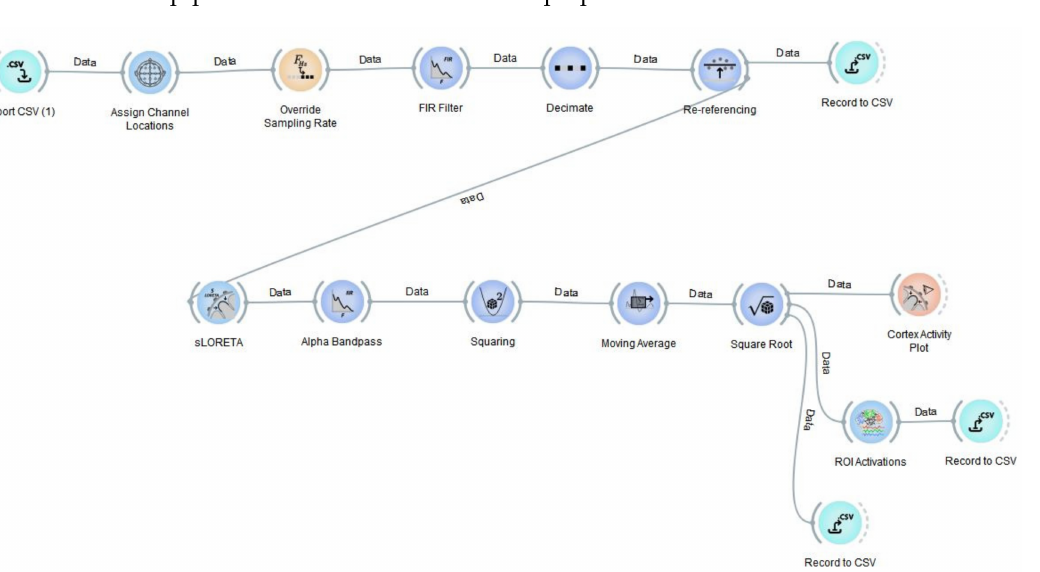
Figure 2. We used python-based Neuropype pipeline to process 2D scalp ERP data, which is extracted from EEG data after artifact removal, for source localization. The obtained current density estimates of voxels belonging to the same region is averaged for getting ROI activations for determining source localization estimates in a CSV output